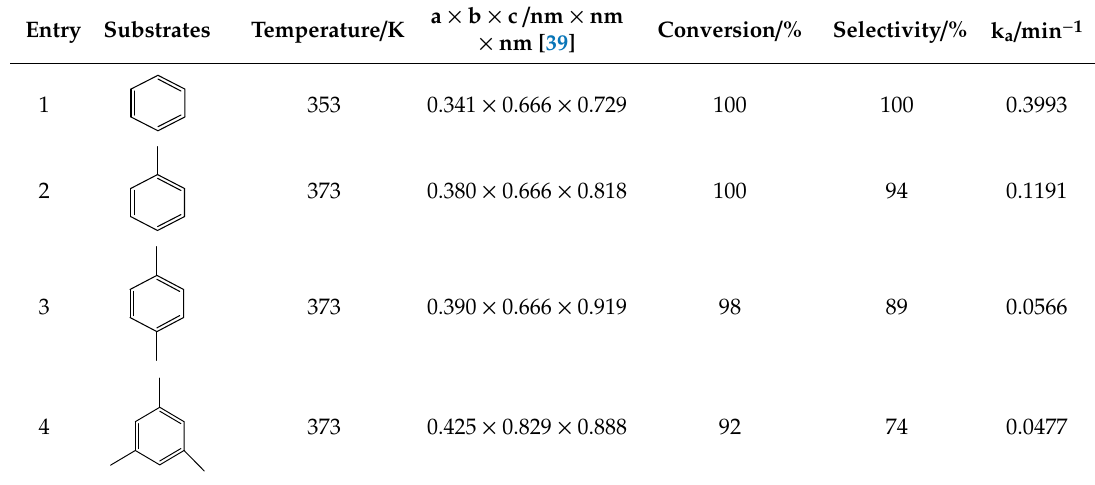
Table 2. Benzylation of aromatics and benzyl alcohol catalyzed by H β -3.